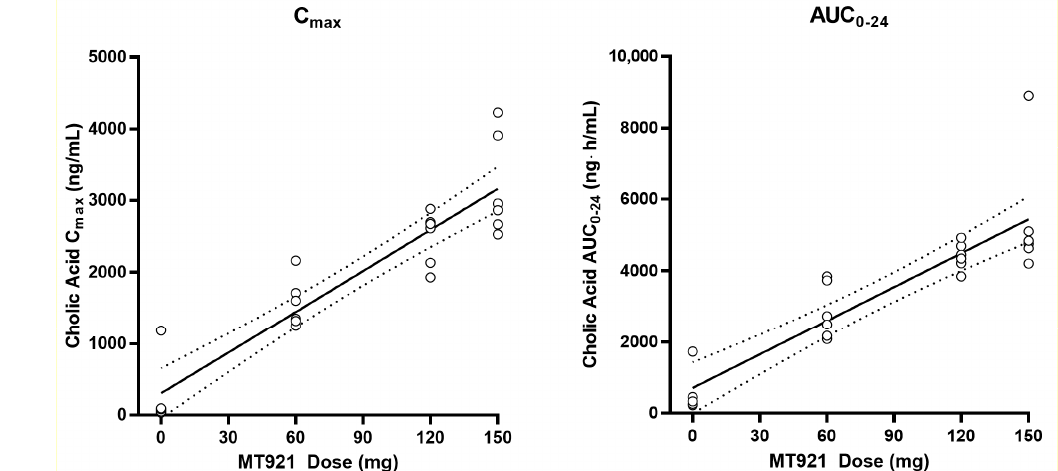
Figure 2. Pharmacokinetic dose-proportionality assessment of cholic acid after administration of MT921.